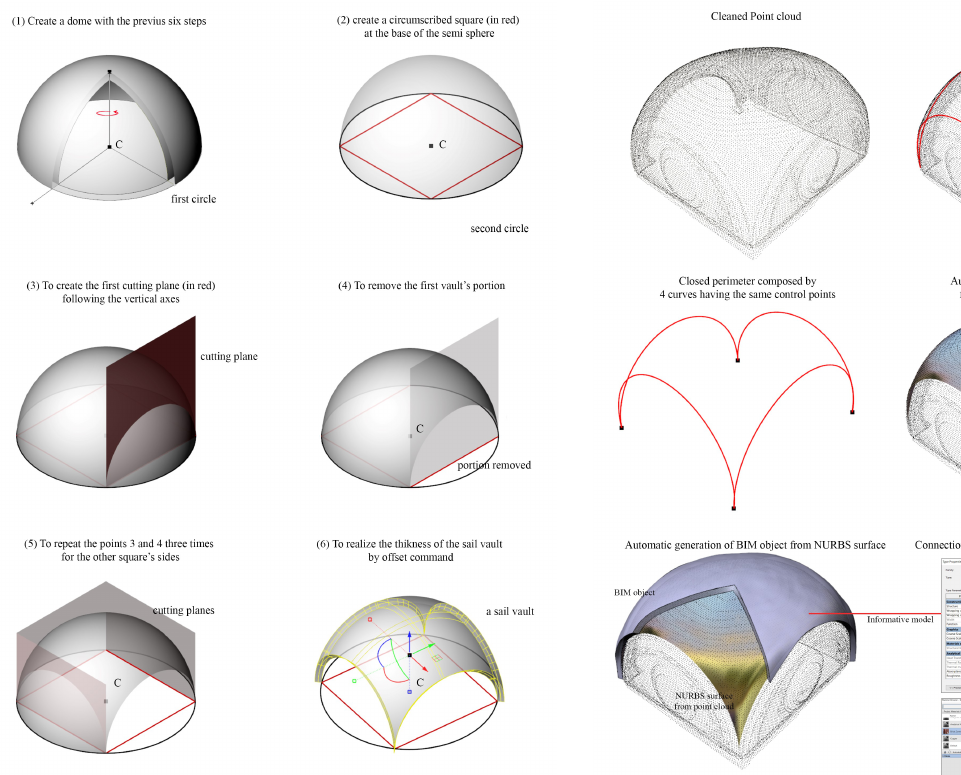
Figure 11. The research method: ‘how to model a sail vault by GOG 10’. Thanks to GOG 10, it is possible to extract the 3D edge from cleaned point clouds and to create a complex vault automatically, corresponding exactly to the detected